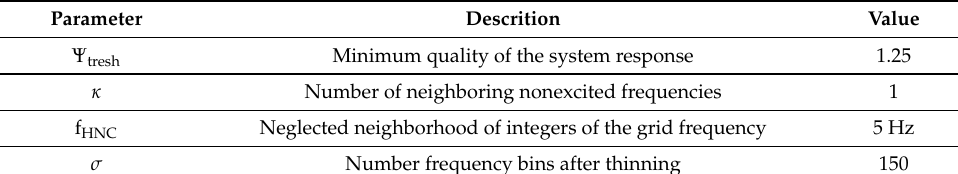
Table 3. Parameters of excitation sequence.